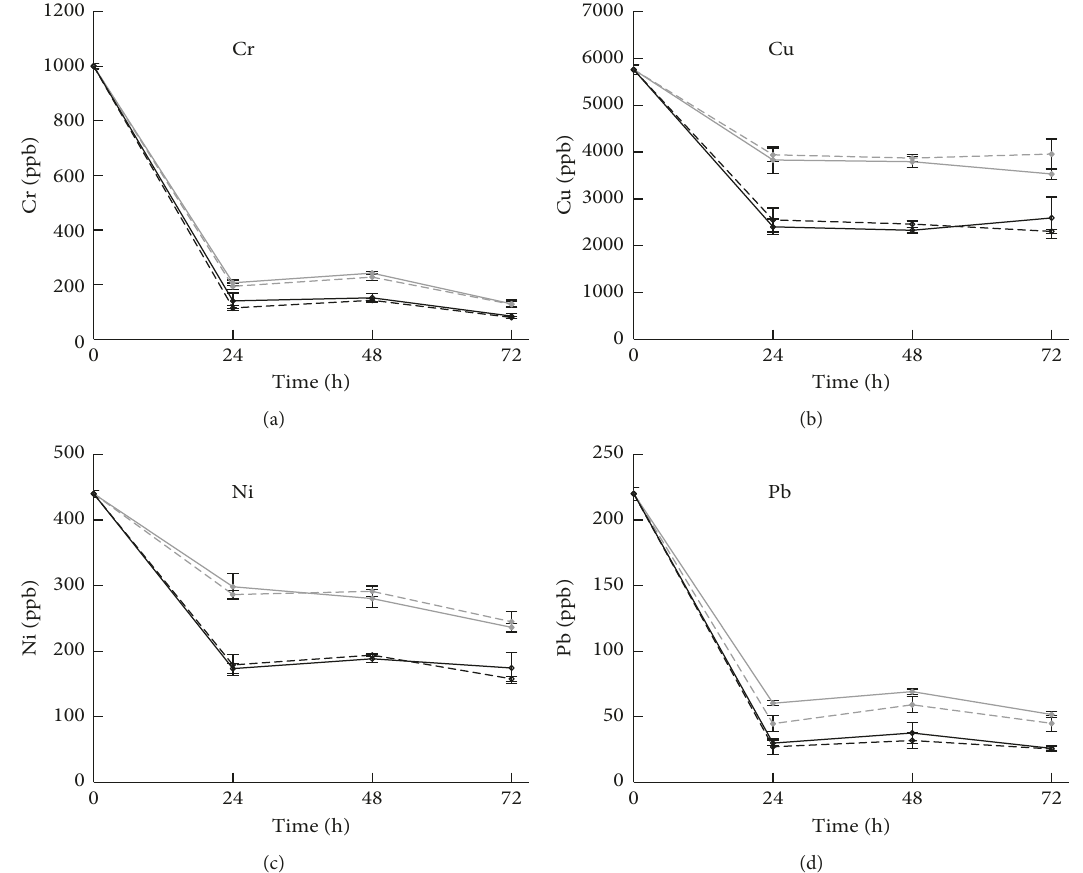
Figure 6: Cr, Cu, Ni, and Pb concentration as a function of time in acetate buffer (5 · 10 − 3 M) for Colonies 1 and 2 at 1:10 and 1:1 Water Kefir/metal solution ratios. Conditions: 5% sucrose and initial pH � 4.5. n �